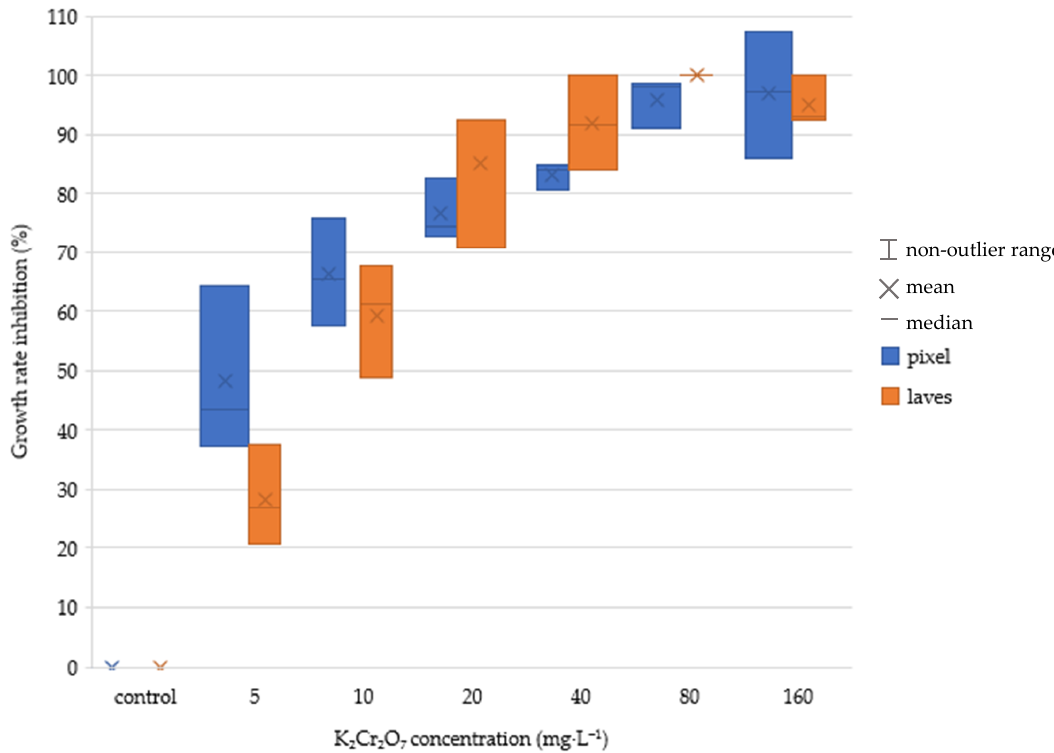
Figure 8. Box and whisker plot of the growth rate inhibition for pixels and the number of leaves.